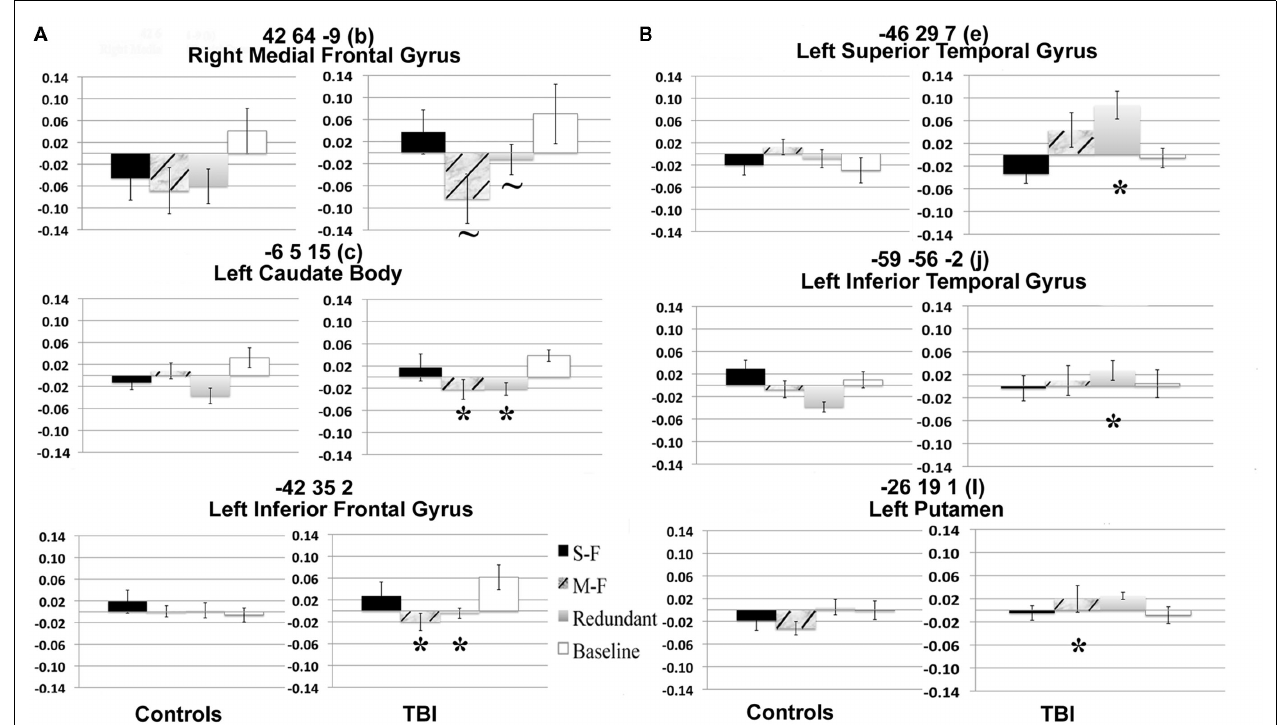
baseline conditions. Letters and coordinates correspond to peaks specified in Table 2A . (B) Selected regions with negative saliences show a greater hemodynamic response forTBI patients than controls on either the multi-feature or the redundant condition. * = Significantly greater response in TBI patients than controls. Letters and coordinates correspond to peaks specified in Table 2B .